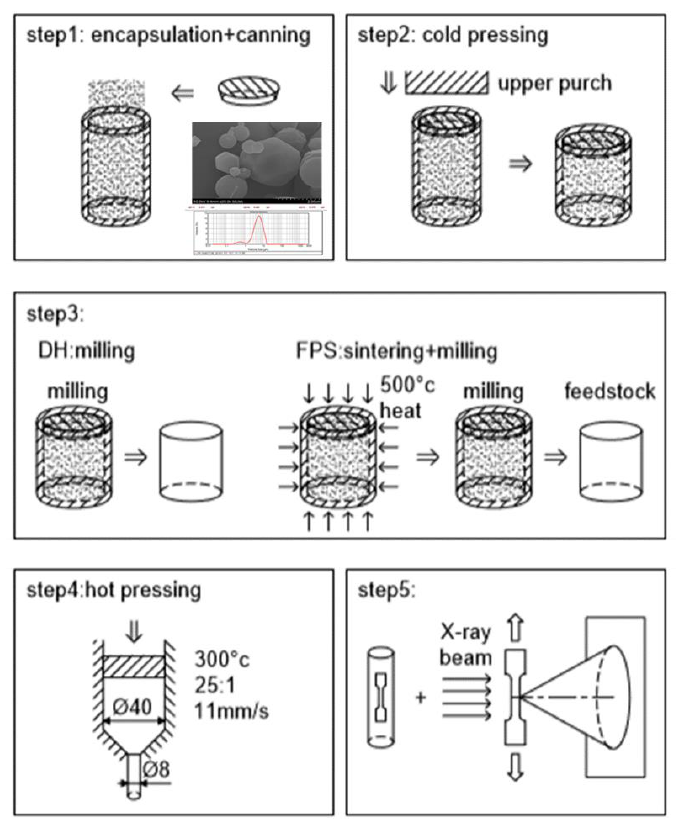
Figure 1. Powder metallurgy (PM) process flow and sample position of tensile samples.